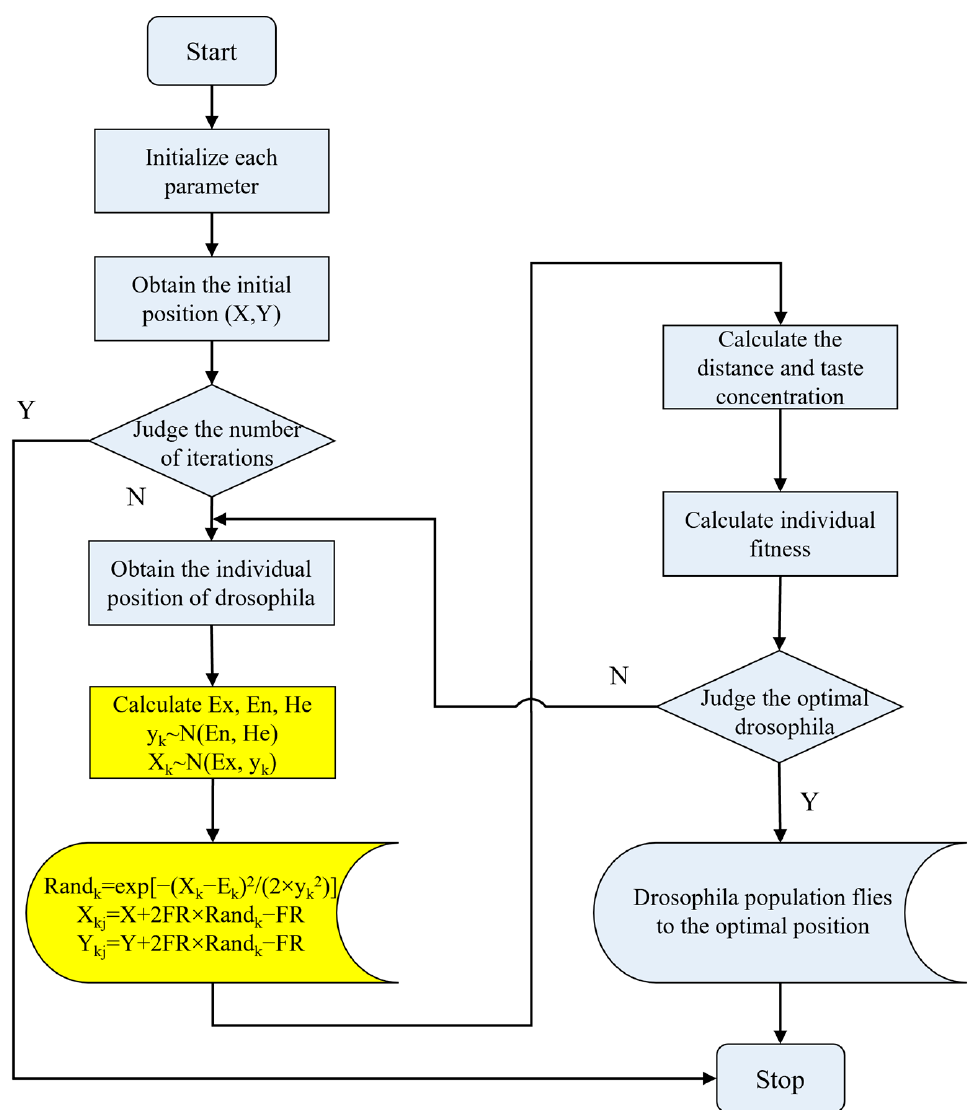
Figure 9. Improved fruit fly algorithm flowchart.